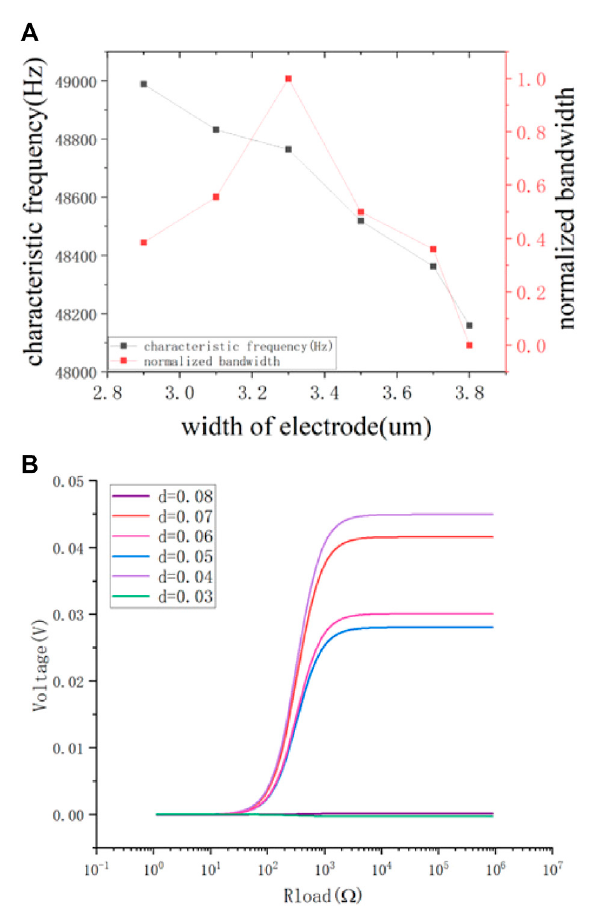
TABLE 3 Structural parameters.